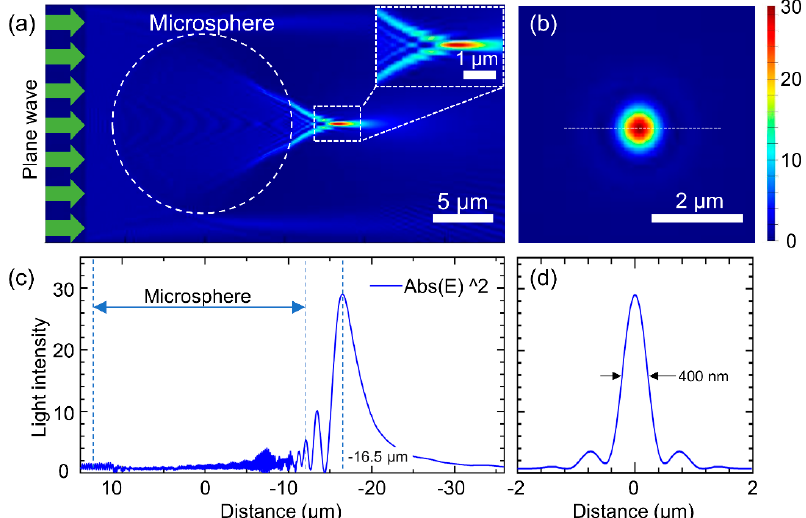
Figure 4. FDTD simulation of the light field distribution of the PNJ. ( a ) Setup of the PNJ simulation. The incident light intensity was normalized, with the color bar representing the scaled light intensity. The inset shows the magnified PNJ. ( b ) The light field distribution in the xy-plane of the PNJ. ( c ) The light field distribution along the z-axis of the PNJ. The horizontal axis represents distance, and the vertical axis represents the energy intensity of the light field. The center of the microsphere coincides with the zero point of the horizontal axis. ( d ) Prolife centered about the dotted line in ( b ).